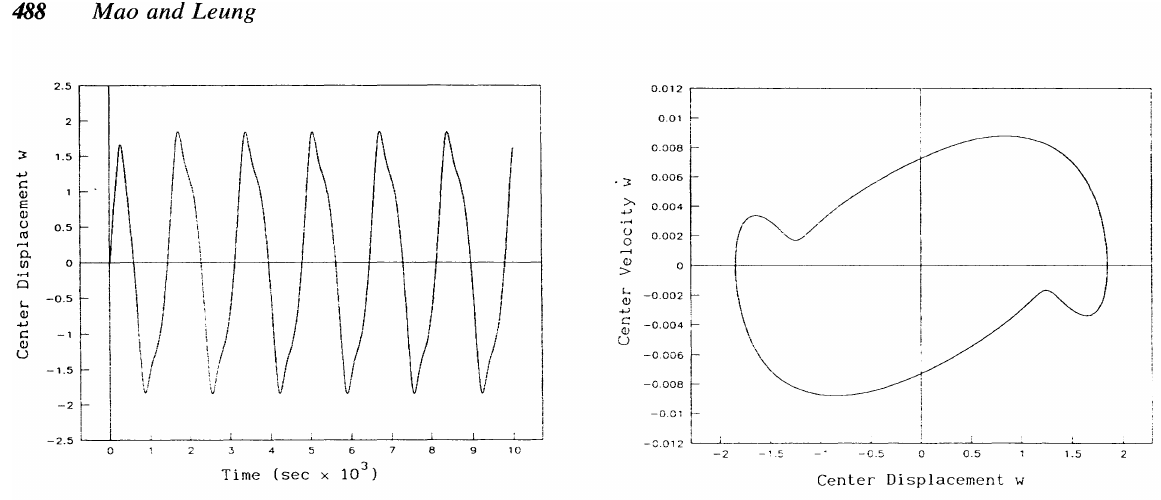
FIGURE 5 Midspan displacement of a hinged beam. FIGURE 6 Midspan phase plane trajectories of steady-state motion of a hinged beam. centered Euler scheme. In Fig. 8, the deflection 8 defined as deflection ratio is measured. Figure 8 shows that at Po = 0.202, it oscillates about a position of 8 = vertical displacement at apex approximately 8 = -0.5, and that at Po = 0.203 it average rise to arch = H/2 snaps through at 7 = 60.0, and it oscillates about a position of approximately 8 = -4.0. Therefore, is used. The dynamic buckling of the arch occurs for 7 from 0 to 90.0, the buckling load predicted at the load level at which a sudden increase in the here lies between ITo = 0.202 and Po = 0.203. For